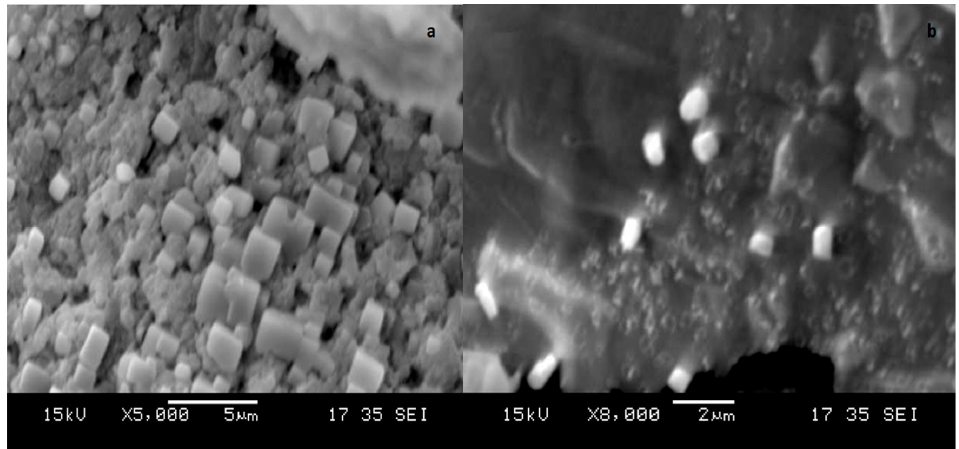
Figure 7. SEM micrograph of ( a ) silver and ( b ) gold nanoparticles synthesized by Thraustochytrium kinnei.